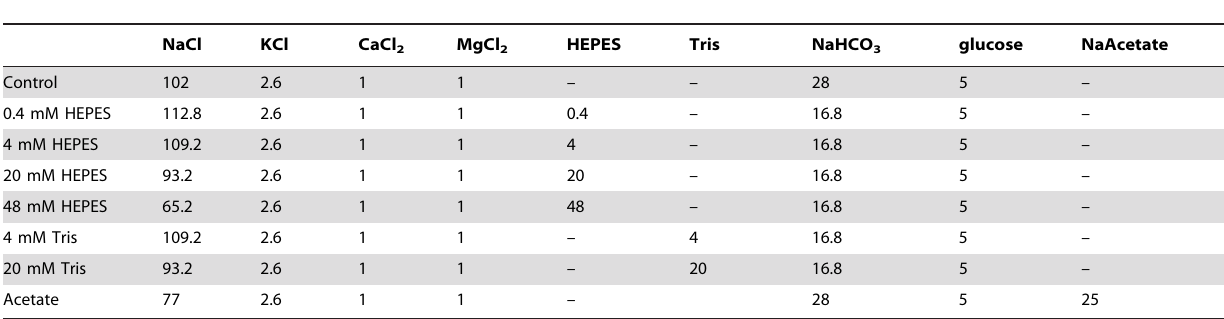
Table 1. Ionic composition of solutions used in this